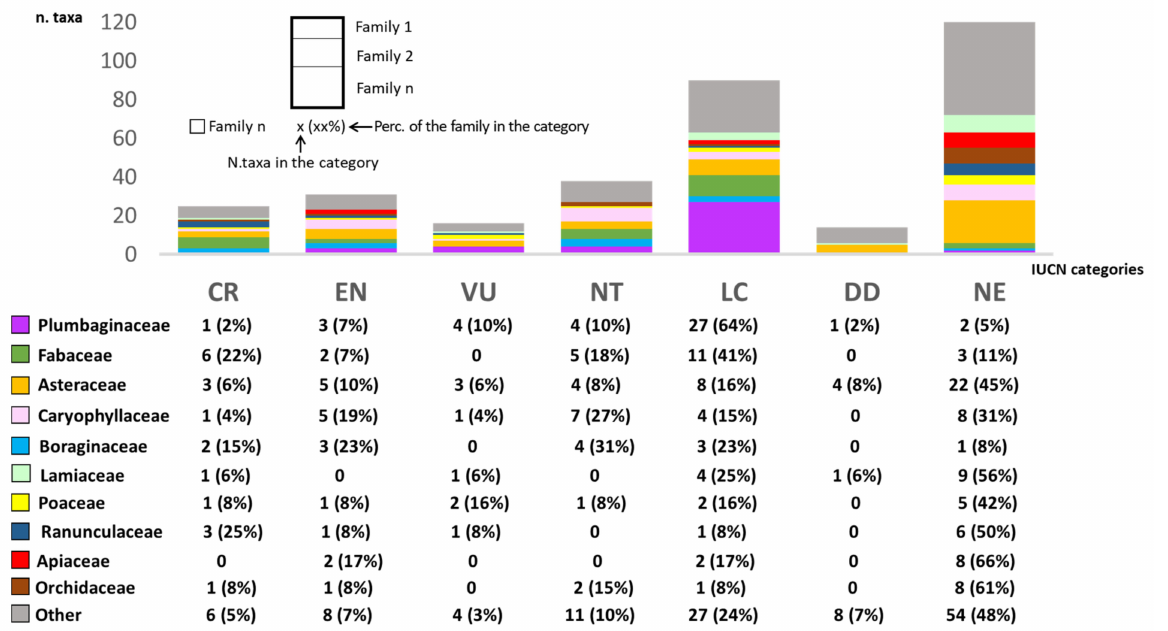
Figure 2. Numbers of vascular plant taxa distributed in the IUCN Red List categories by family. Only the most numerous families in each category were plotted. CR: Critically Endangered, EN: Endangered, VU: Vulnerable, NT: Near Threatened, LC: Least Concern, DD: Data Deficient, NE: Not